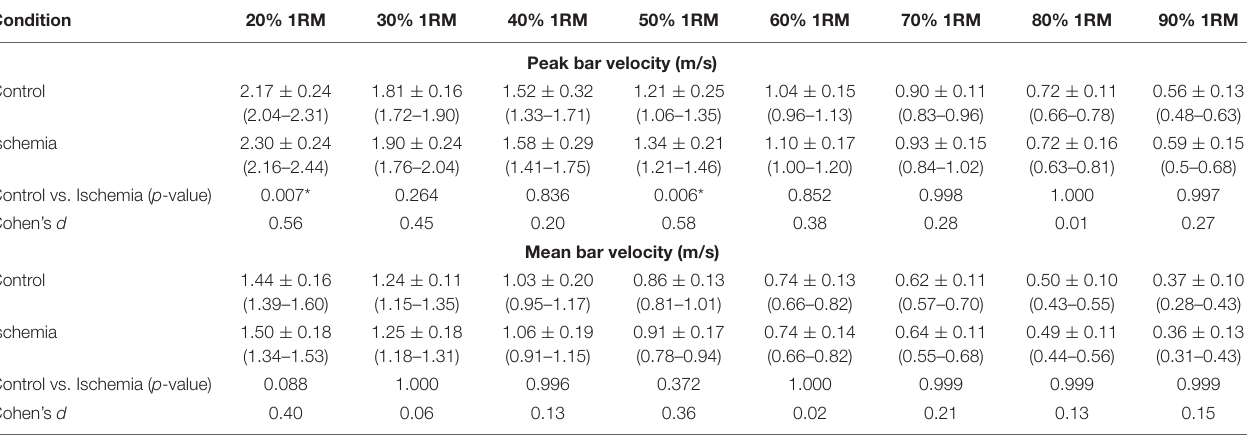
TABLE 1 | Bar velocity during eight sets of the bench press exercise under two conditions.